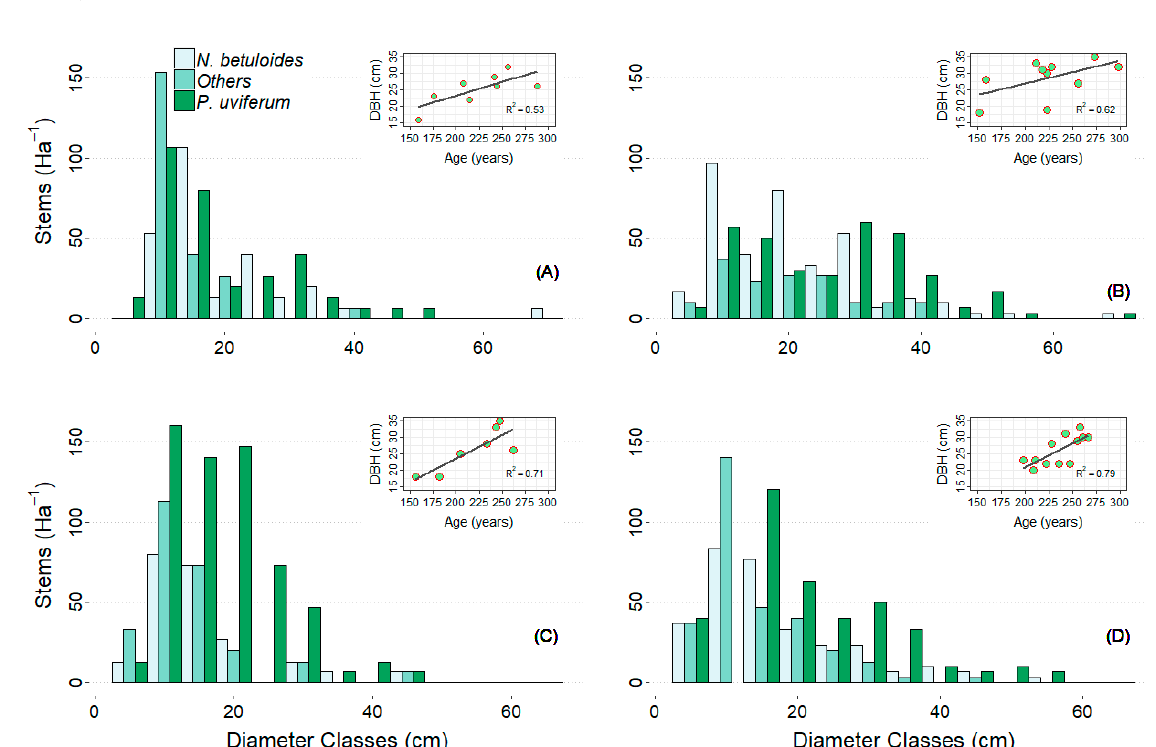
Table 2. General background of the stands measured. H avg = average height; MSD = mean square diameter; D = density; BA = basal area.